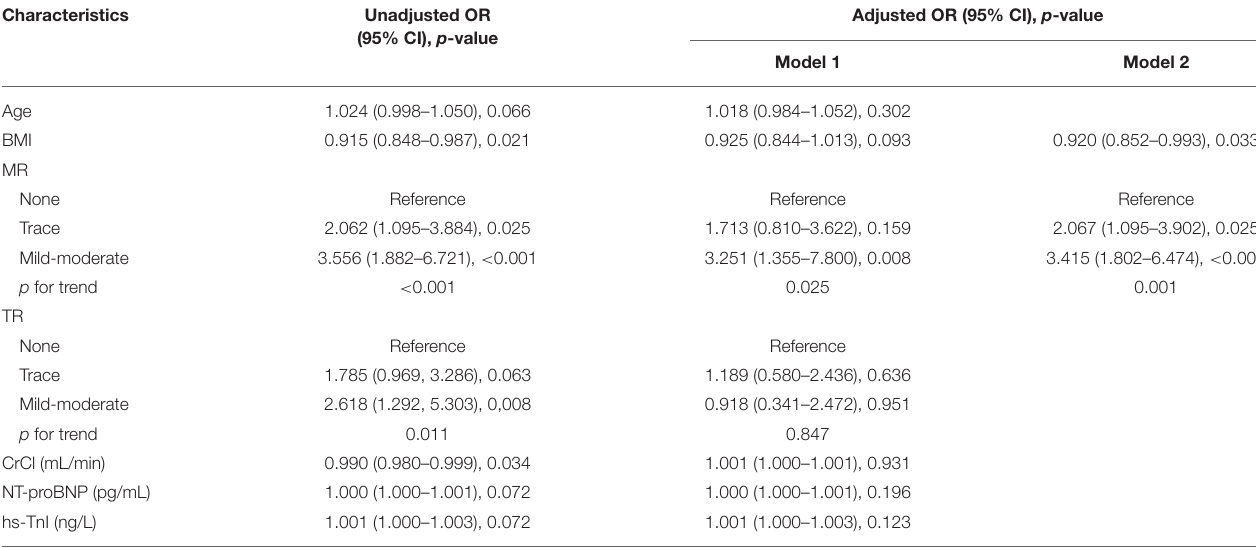
TABLE 2 | Univariate and multivariate logistic regression model of possible indicators for periprocedural bleeding events. Characteristics